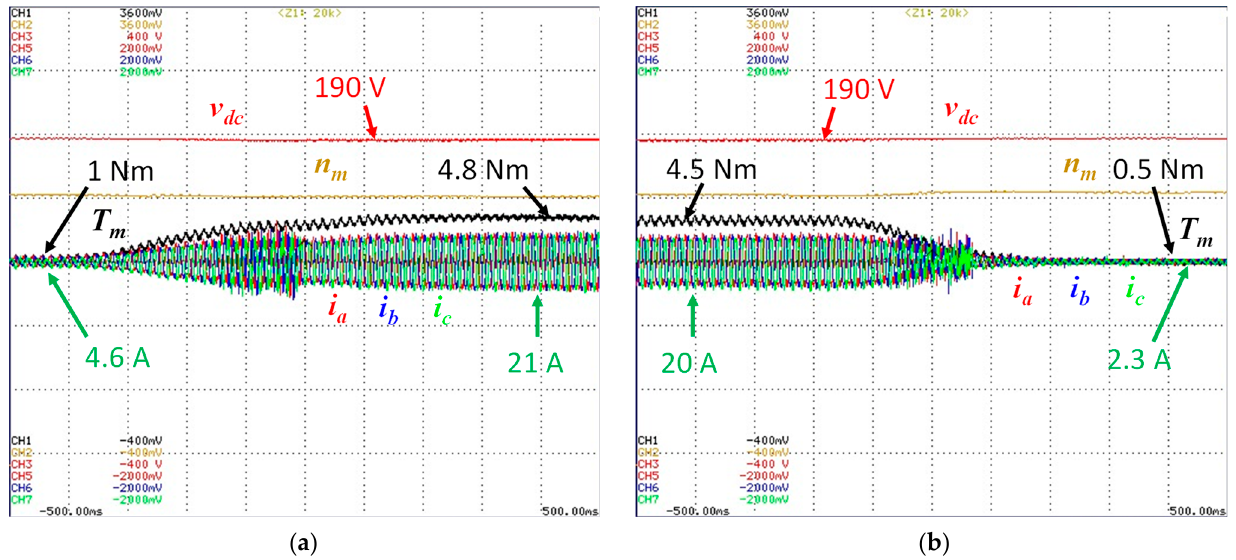
Figure 17. Experimental results of the traction system operating at 1000 rpm: the torque ( T m ) and speed ( n m ) of the SRPM machine; dc-link voltage ( v dc ); and stator windings’ currents ( i a , i b , i c ) when varying the load from ( a ) 0 Nm to 4 Nm and ( b ) 4 Nm to 0